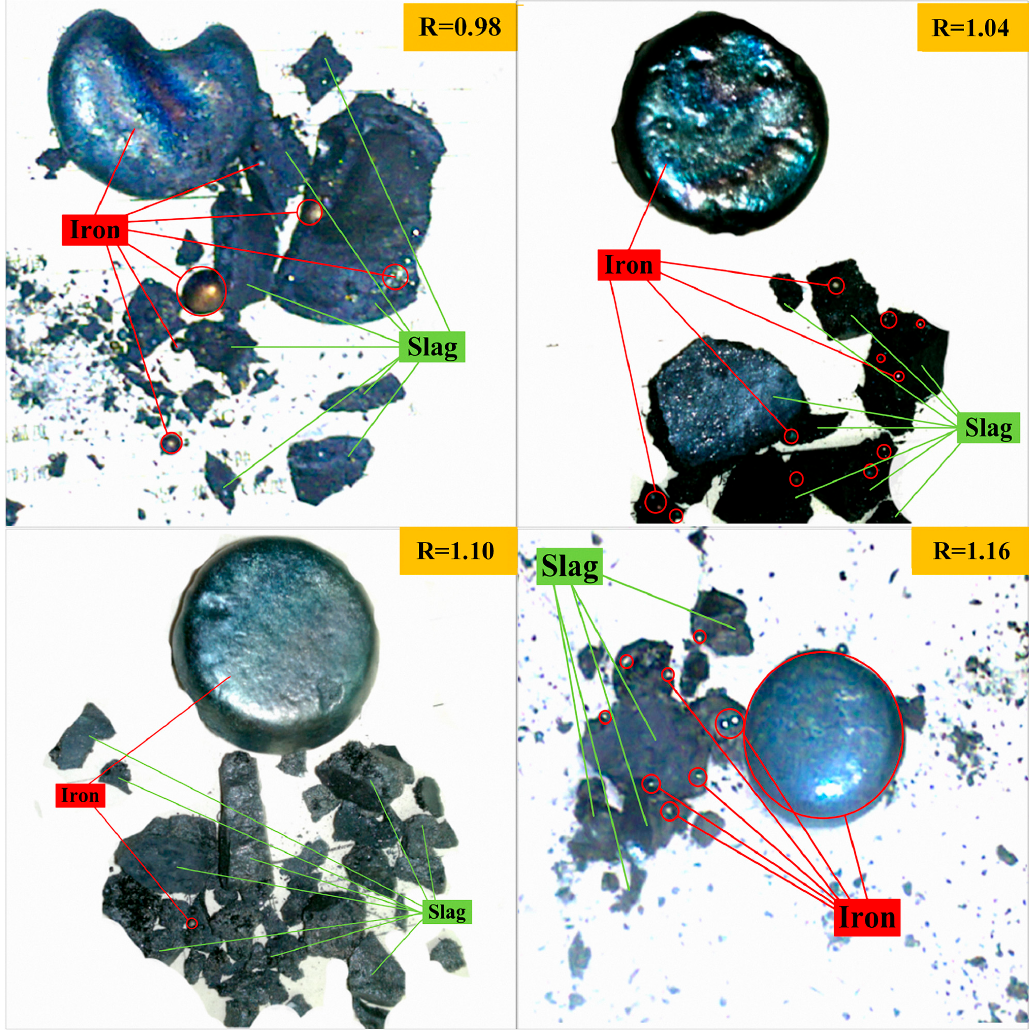
Figure 10. Pictures of iron and titanium slag separation with varying quaternary basicity by addition of CaO.